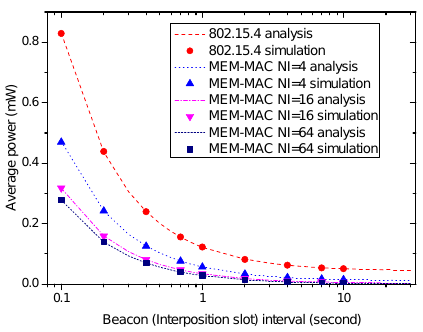
Figure 8. The effects of the beacon frame interval and interposition interval on node average